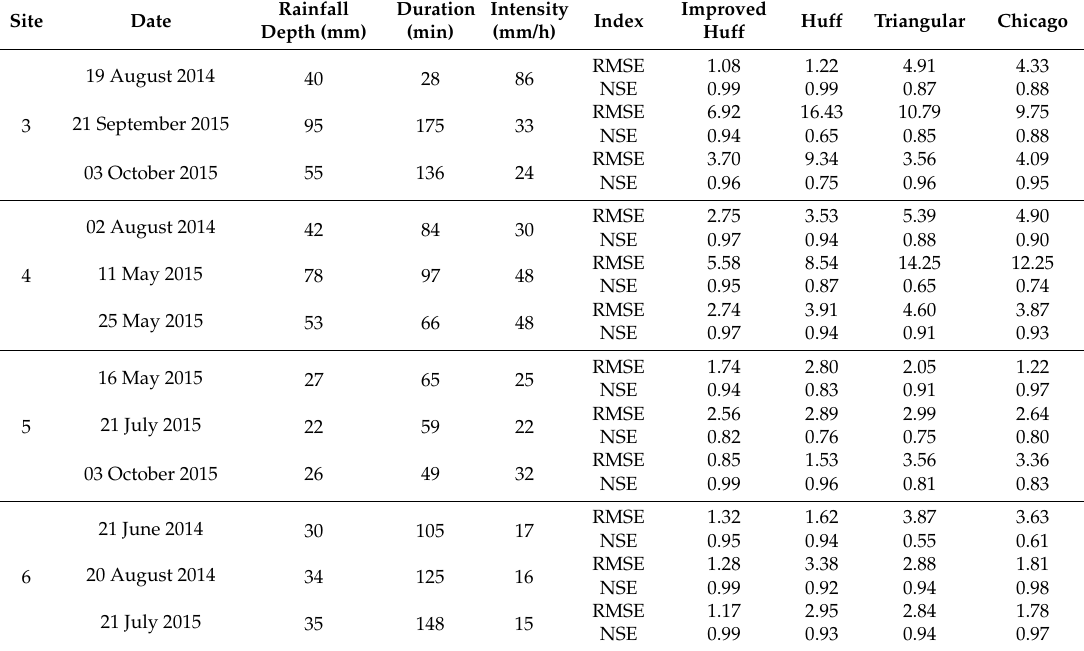
Figure 4. Comparisons of cumulative rainfall between ground observations and the design storms for the storm events at Site 3 on 21 September 2015 ( a ); at Site 4 on 25 May 2015 ( b ); at Site 5 on 3 October 2015 ( c ); and at Site 6 on 21 July 2015 ( d ). Table 5. RMSE and NSE values computed between design storms and observed rainfall at Sites 3-6, where the observed storm data are not used to develop design storms. Both the Improved Huff and original Huff curves represent those at a probability of 50%.